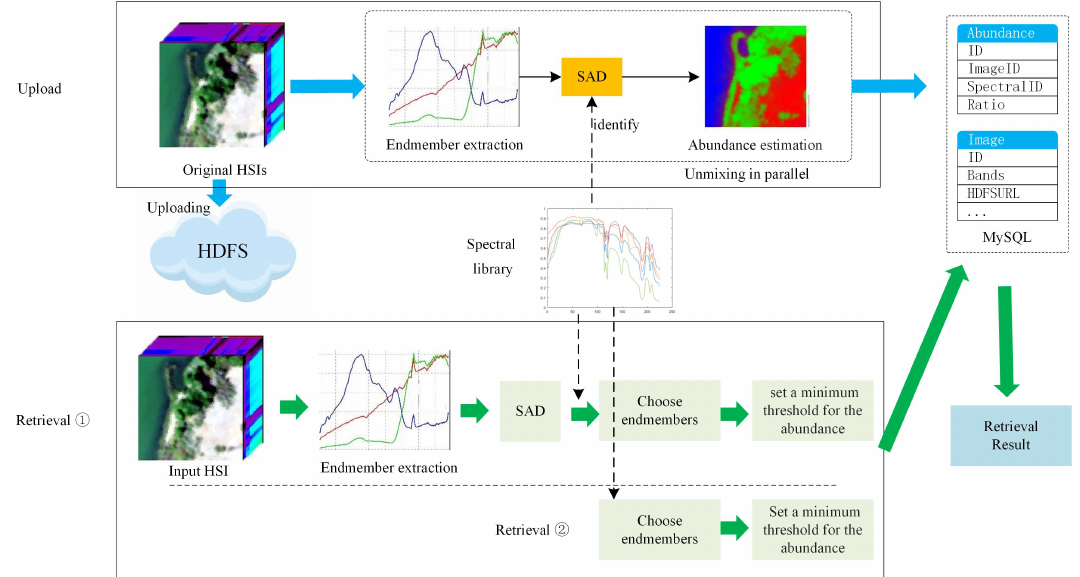
Figure 4. The unmixing-based CBIR flowchart of HSIs in the proposed